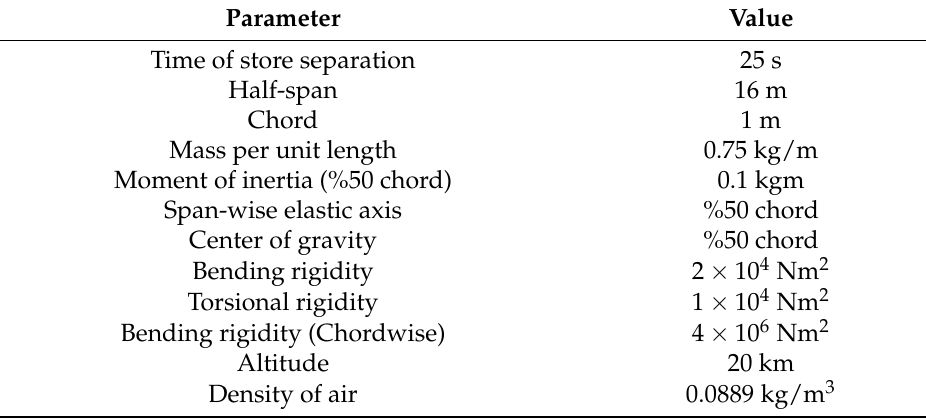
Table 3. Parameters of the aircraft model [26].